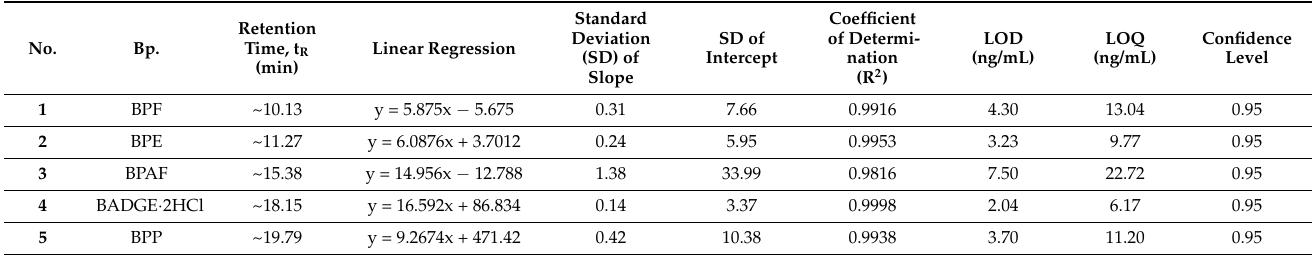
Table 4. Method validation parameters used for calibration curves in averaged amniotic fluid blank sample: retention times, calibration curve equations, standard deviations of slopes and intercepts, determination coefficients (R 2 ), limits of detection (LODs), limits of quantification (LOQs), and confidence